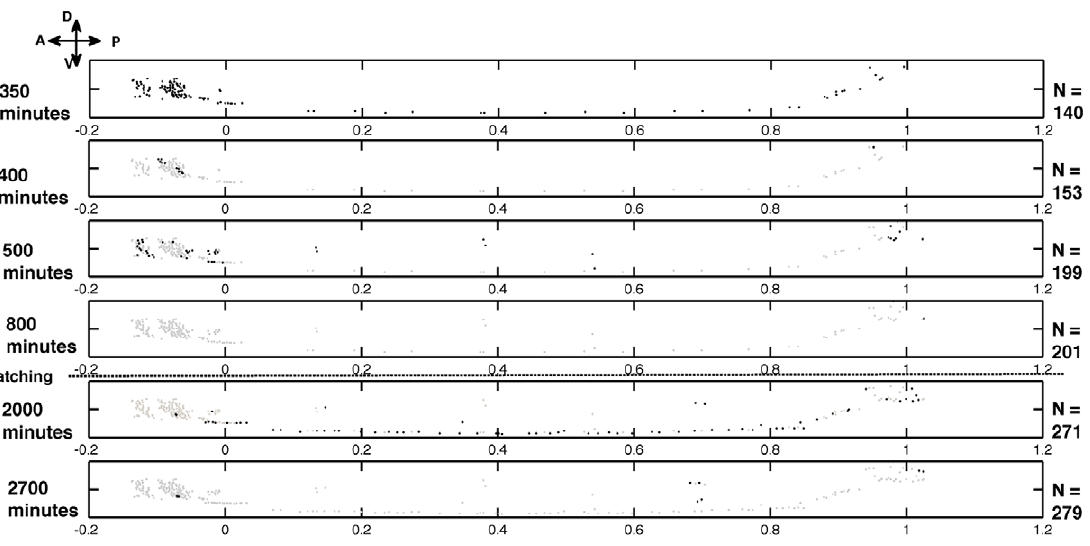
Figure 1. Growth of the neural network represented in six discrete time stages, providing a convenient visualization of the various neurons appearing before (gray) and during (black) the respective time stages. Orientations are along the Anterior (A)-Posterior (P), and Dorsal (D)-Ventral (V) axes. The horizontal dashed line indicates the approximate time of hatching (840 minutes). For any stage, the dots in grey are the neurons that have already appeared, while the black dots indicate those that appear by the end of that particular stage.